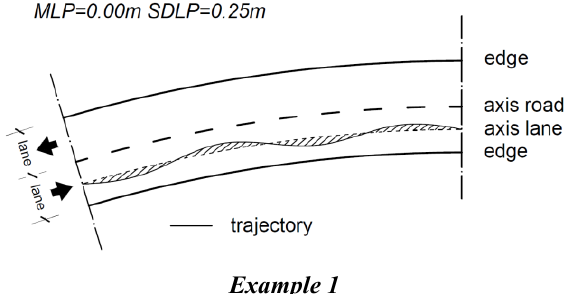
Figure 1 Example 1, driving close to the lane axis with little variability in position and remaining in the lane; Example 2, a more central position around the centre line (the road axis), also enter- ing the opposite lane; and Example 3, the same average position around the lane axis as in Ex- ample 1, but with more lateral variability. See also the main text for further